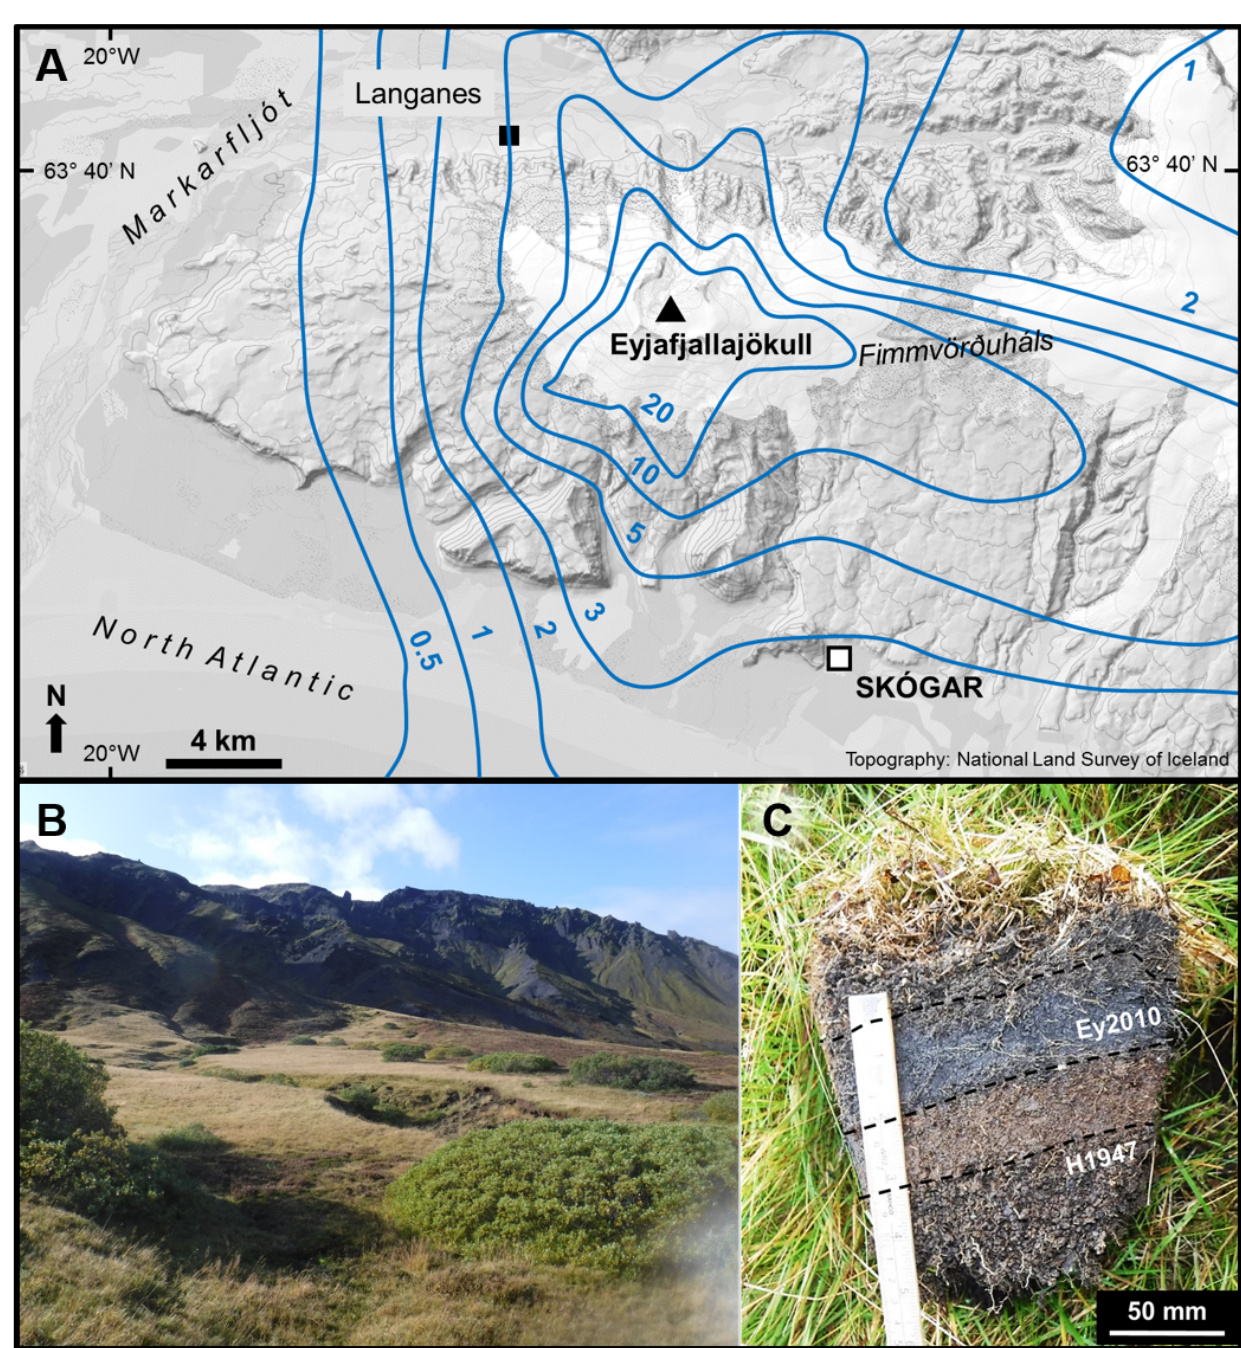
Figure 2: [A] Isopach map of the tephra deposit from the Eyjafjallajökull eruption of 2010 (Ey2010), showing the study location at Langanes. Isolines (cm) are based on Gudmundsson et al. [2012a]. Underlying topography provided by National Land Survey of Iceland [2012]. [B] Overview of the Langanes area showing isolated tall shrubs and the slopes of the volcano in the background. [C] Sample section at Langanes showing tephra from Eyjafjallajökull (2010) near the surface. The tephra layer from the Hekla (1947) eruption was identified at the base of this section, as identified by its stratigraphic context, physical characteristics and section location in relation to the known fallout area [Thorarinsson 1954]. Dashed lines show the indicative contacts between tephra and